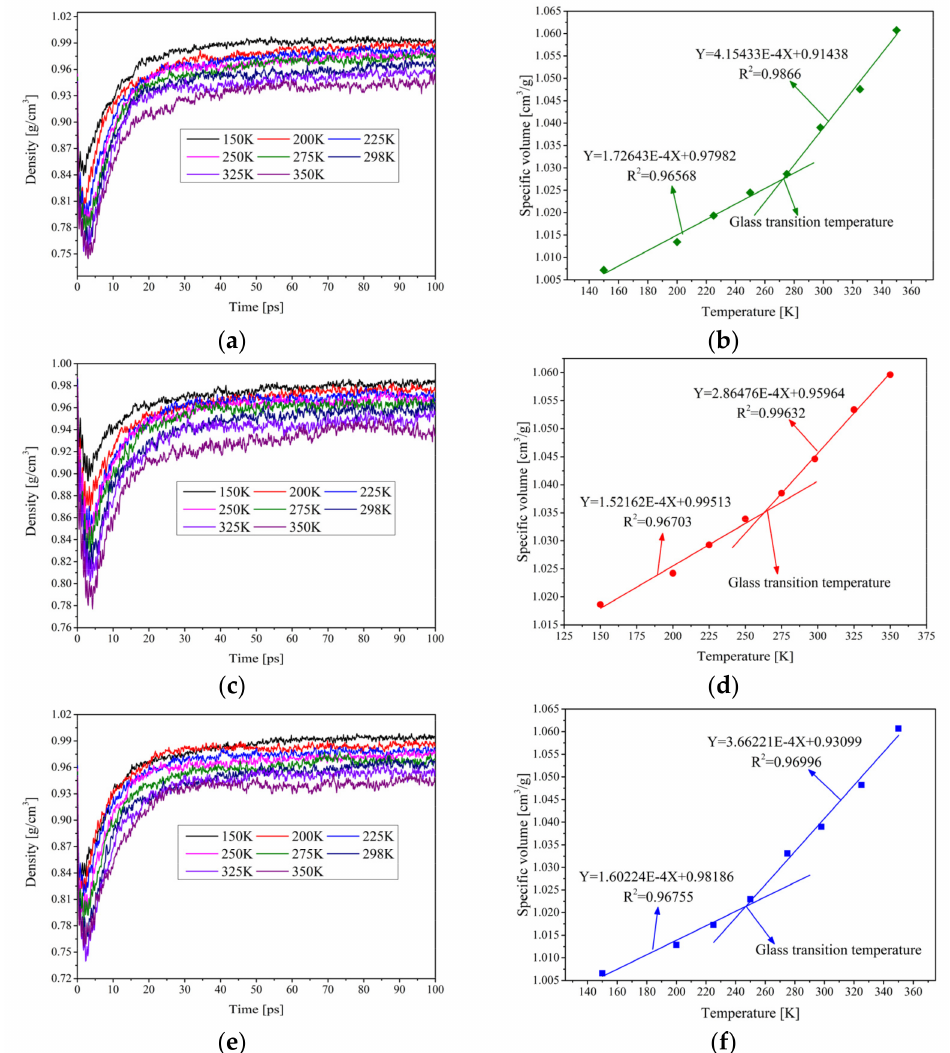
Figure 8. Density ( a ) and glass transition temperature ( b ) of virgin asphalt at different temperatures, density ( c ) and glass transition temperature ( d ) of RPE-modified asphalt at different temperatures, density ( e ) and glass transition temperature ( f ) of CNT-RPE-modified asphalt at different